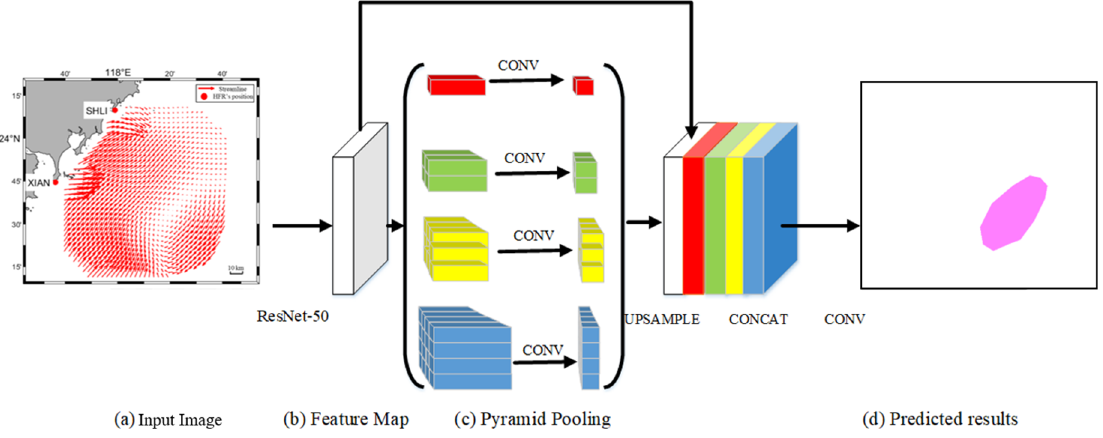
Figure 3. The DEDNet’s structure.